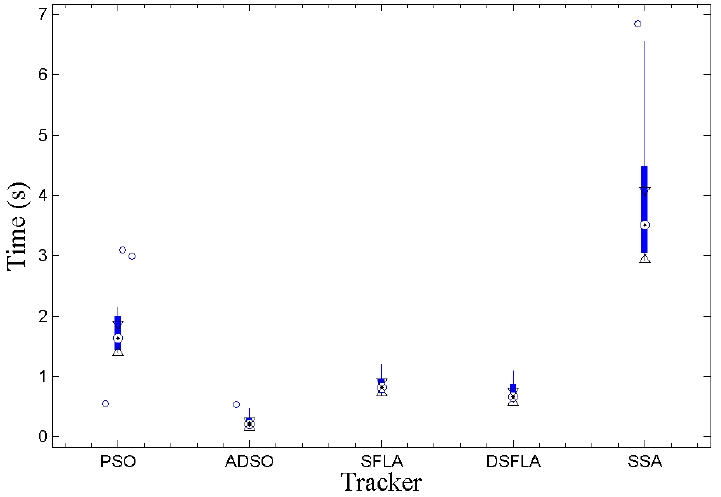
Figure 2. The boxplot of the variable processing time per frame for all trackers.